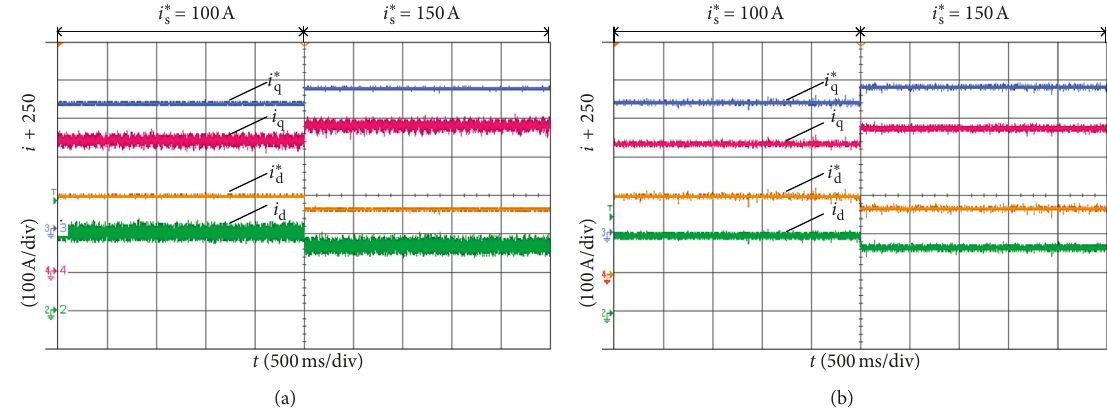
Figure 13: d- and q-axis current waveforms. (a) The conventional MPC-RCMV. (b) The proposed MPC-RCMV with constant switching frequency.